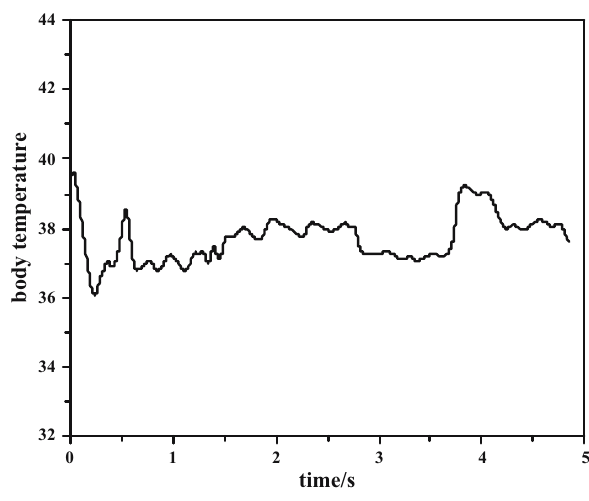
Figure 6: Temperature curve display.